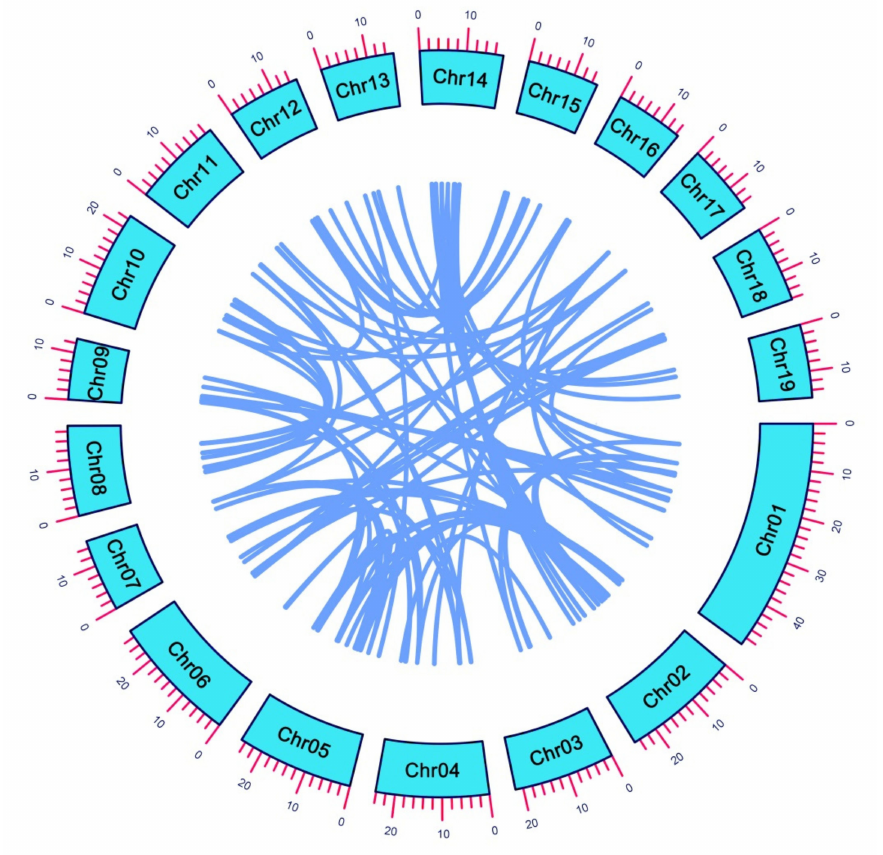
Figure 6. Chromosomal location and synteny analysis of poplar PtrHB genes. The Circos diagram indicates the chromosomal location and collinearity of the PtrHB gene in